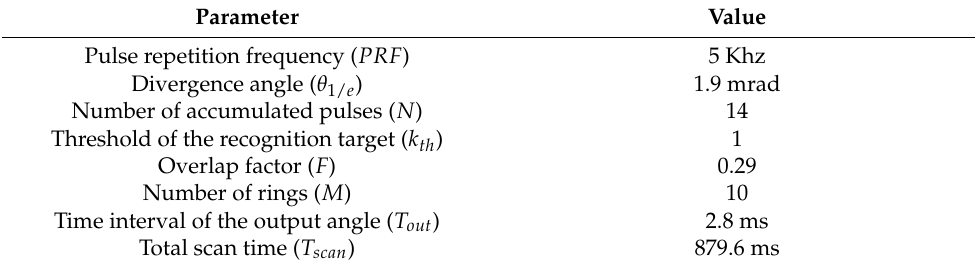
Figure 6. ( a ) Target tracking flowchart and ( b ) the simulation flowchart of the APT of the target. Table 1. Main input parameters of the lidar